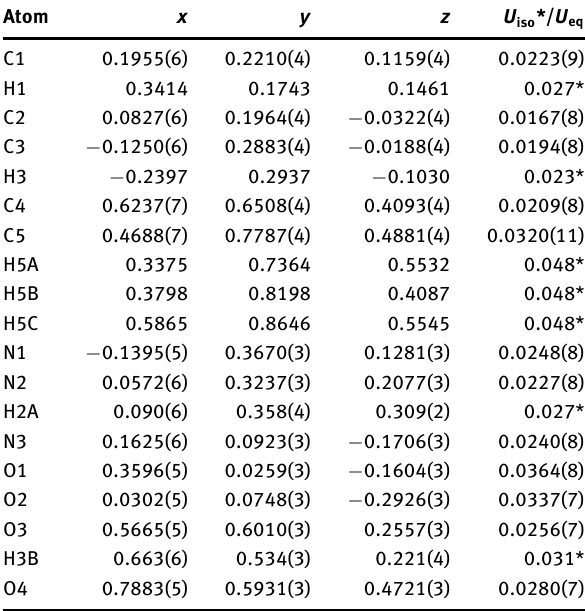
Table 2: Fractional atomic coordinates and isotropic or equivalent isotropic displacement parameters (Å 2